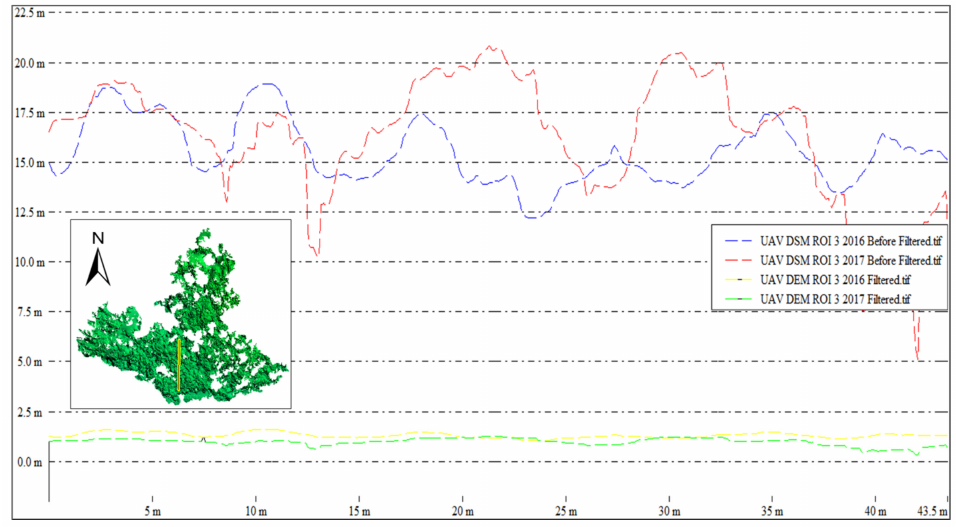
Figure A9. Average height comparison between filtered and unfiltered for ROI